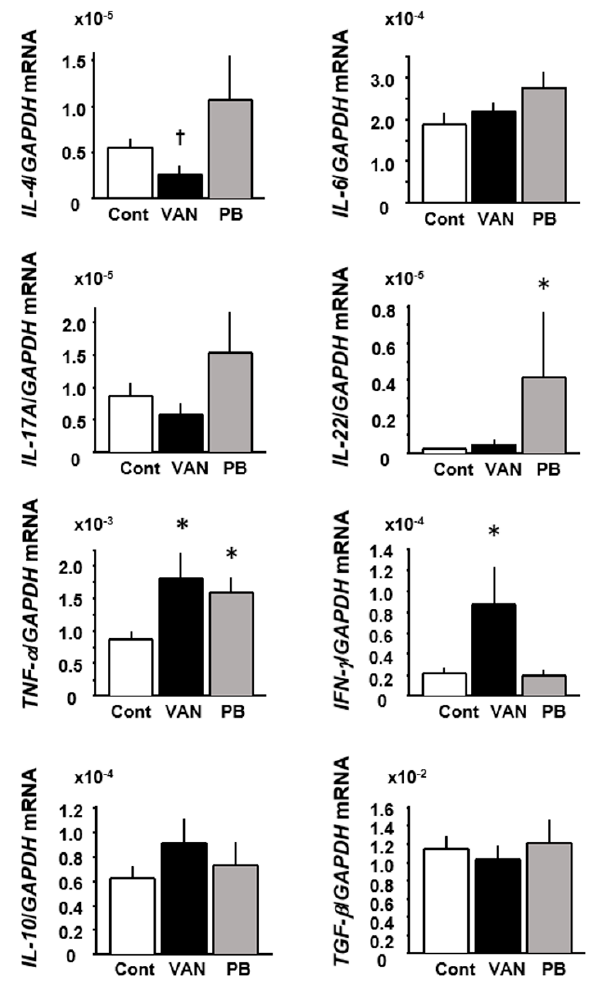
Figure 8. Effect of antibiotic treatment on the expression of cytokine mRNA in mouse colonic tissues. Results are expressed as mean ± SE. Cont, control ( n = 5); VAN, vancomycin ( n = 6); PB, polymyxin B ( n = 5). Significantly higher than in the control: * p < 0.05. Significantly lower than in the control: † p < 0.05.